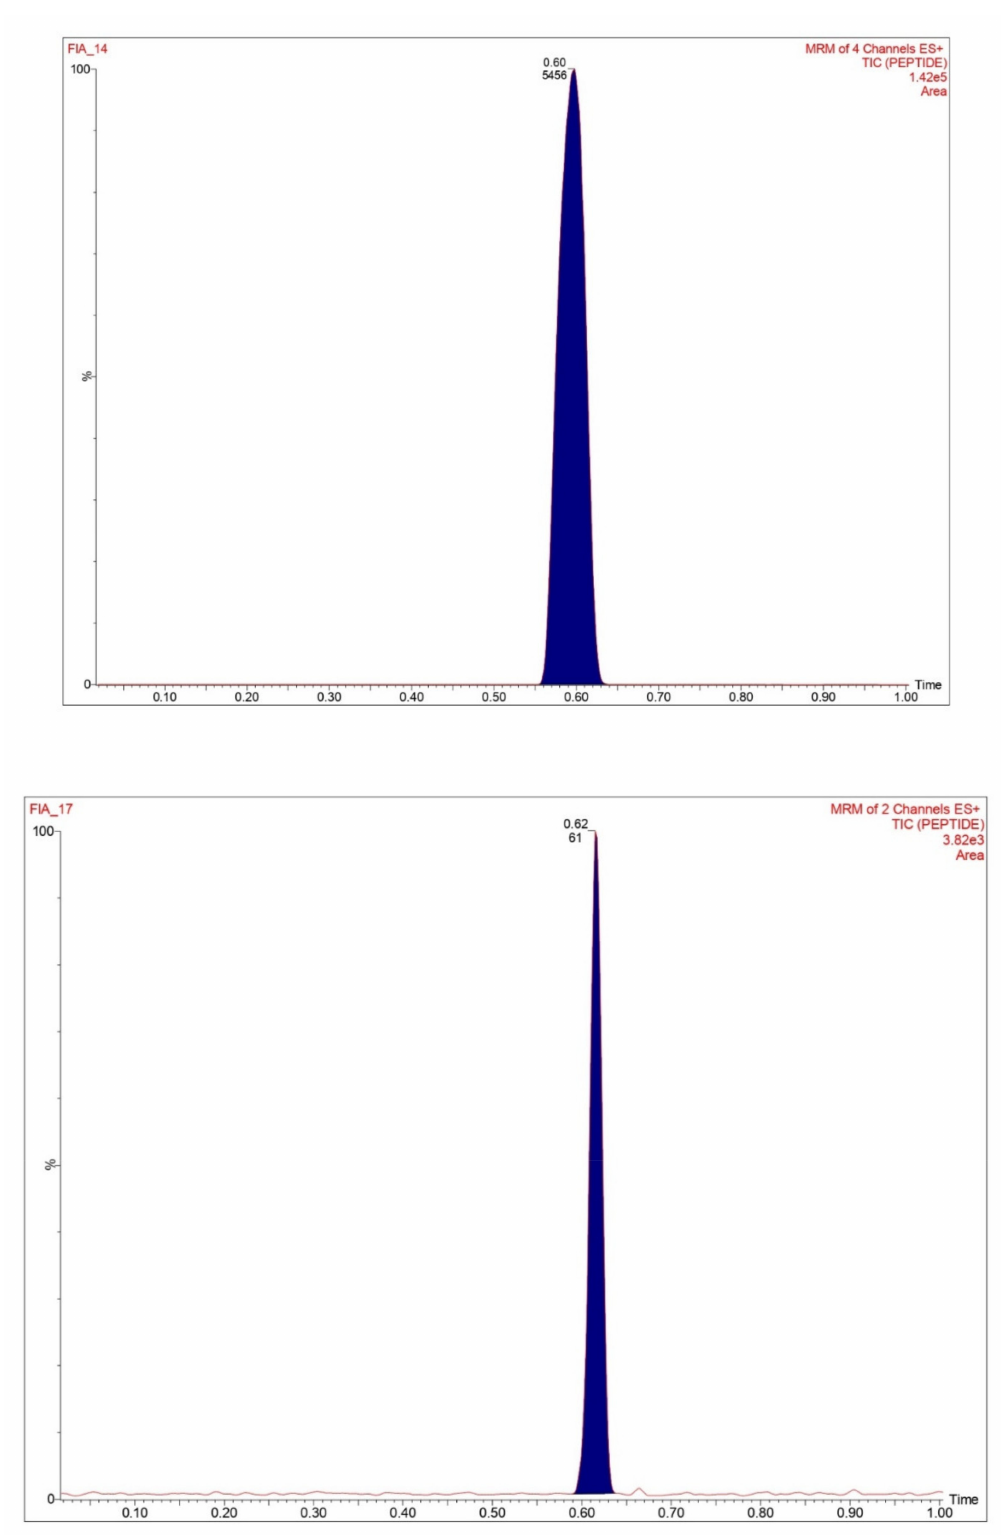
Figure 3. MRM chromatogram of signature peptides, SILuMAB, illustrating signal in spiked plasma